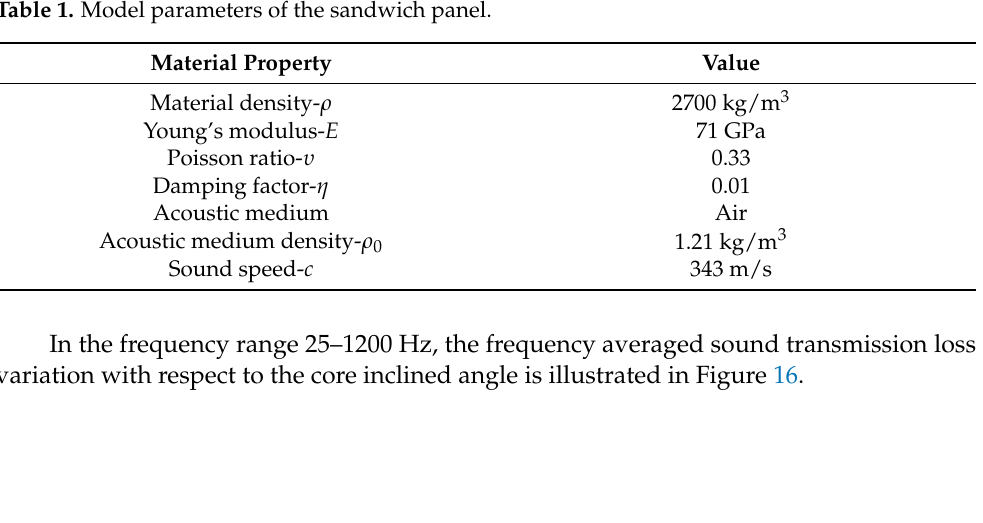
Figure 15. The sandwich panel model used in the optimization.